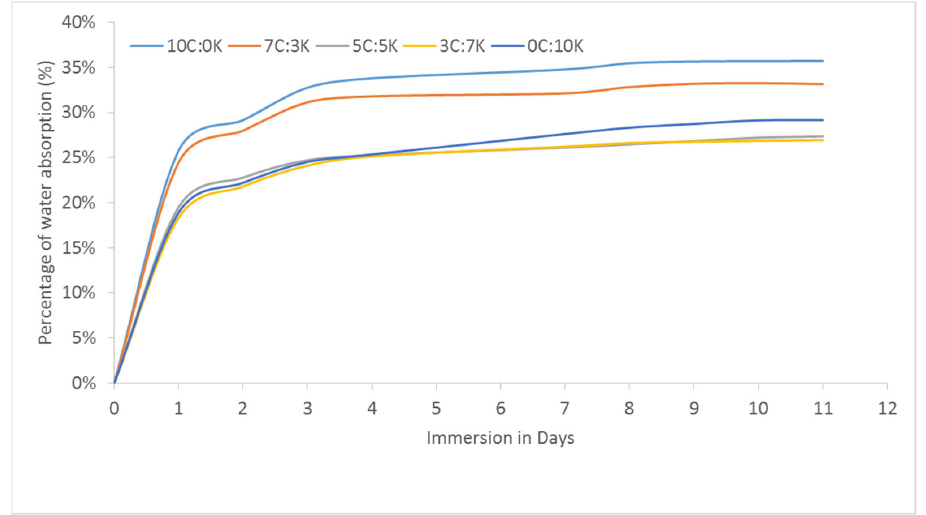
Figure 2. Water absorption percentage of CR and/or kenaf reinforced phenolic composites.